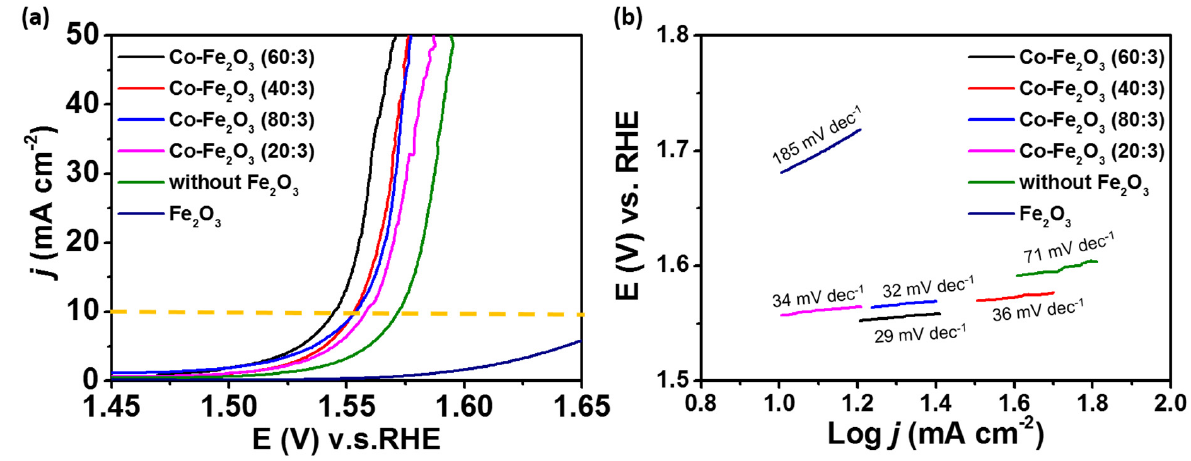
Figure 1. The activity of OER for different ratios between iron and cobalt precursors with iR -compensated. ( a ) LSV curves. ( b ) Tafel slopes.